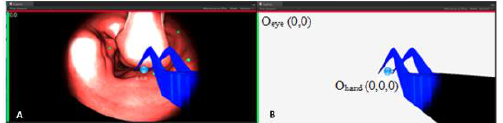
Table 2. Participants’ Surgical Experience